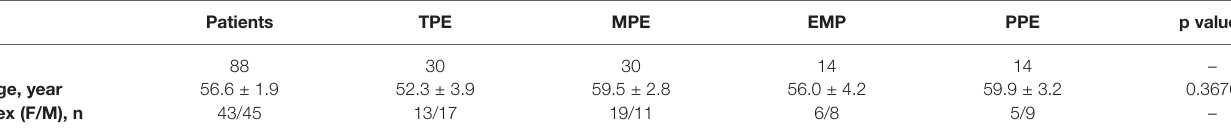
TABLE 1 | Demographic data of the study population. Patients TPE MPE